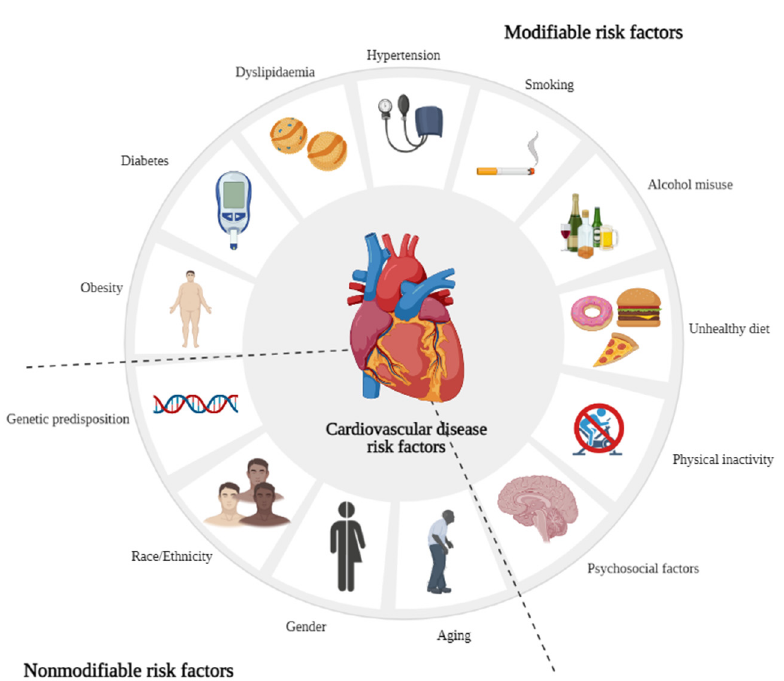
Figure 1. Cardiovascular disease risk factors. Created with BioRender.com.